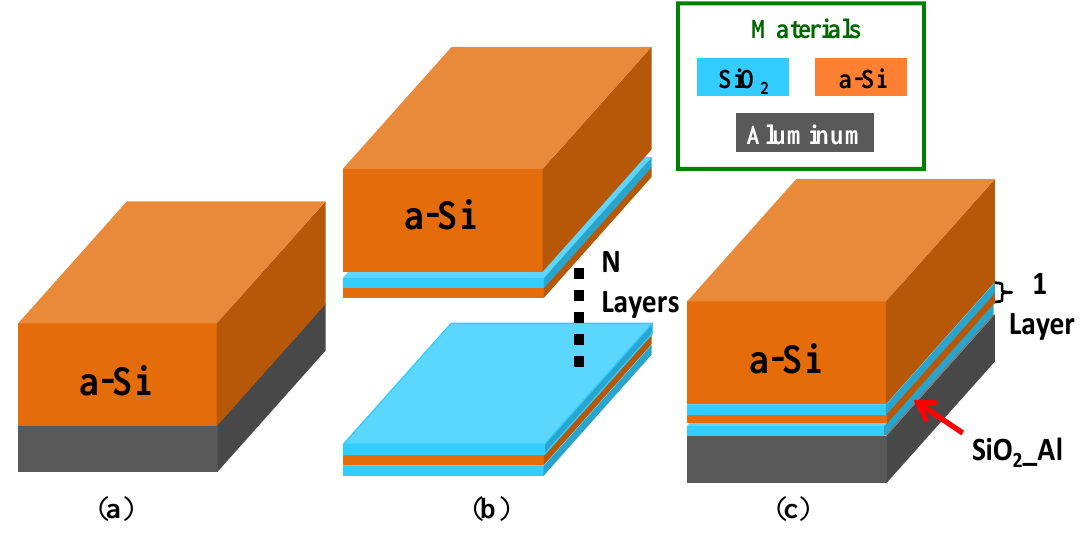
Figure 3. Schematic of an a-Si structure atop, (a) an aluminum reflector, (b) a standard multilayer DBR structure with a large number (N) of layers, (c) a reduced layer, hybrid dielectric-metallic back